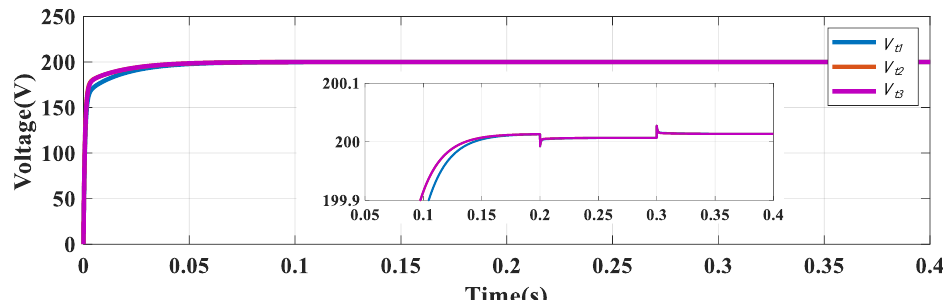
Figure 8. Study 1: output voltage of each DG.